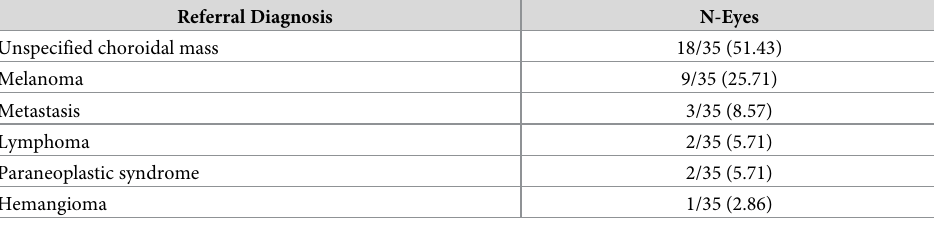
Table 2. Referral diagnoses before PEHCR diagnosis.